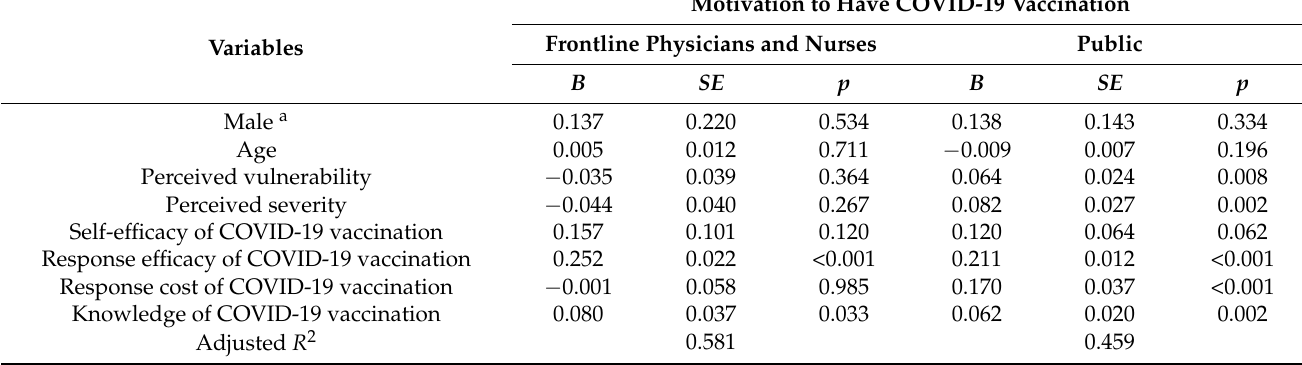
Table 4. Constructs of PMT as Related to Motivation to Receive COVID-19 Vaccination in Frontline Physicians and Nurses and the Public: Multiple Regression